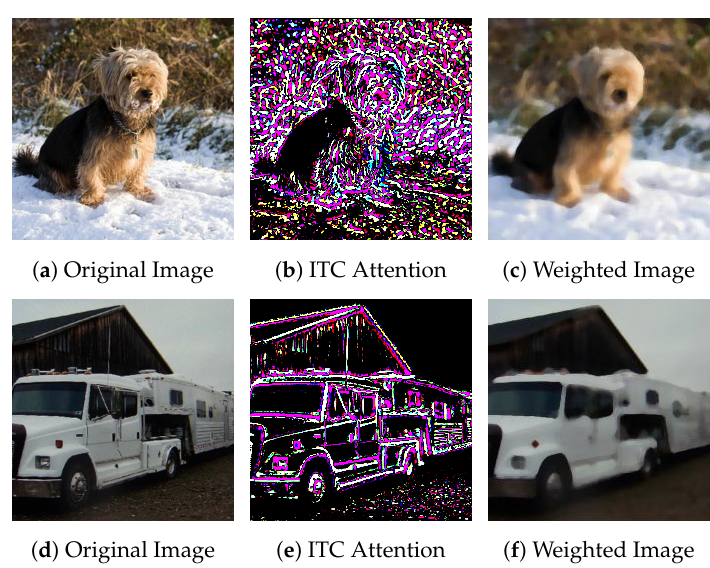
Figure 8. The effect of ITC attention on texture complexity